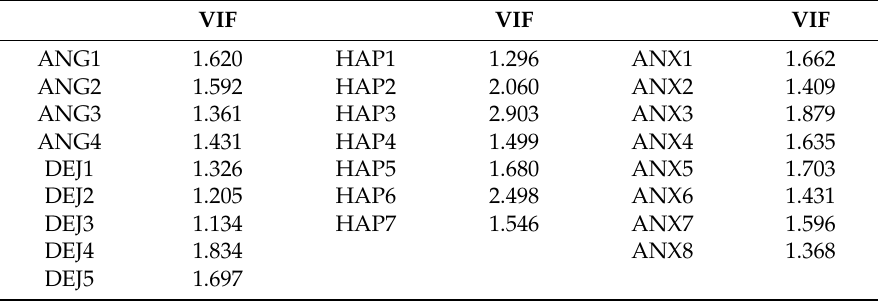
Table 3. Variance inflation factors (VIF) values for all exogenous